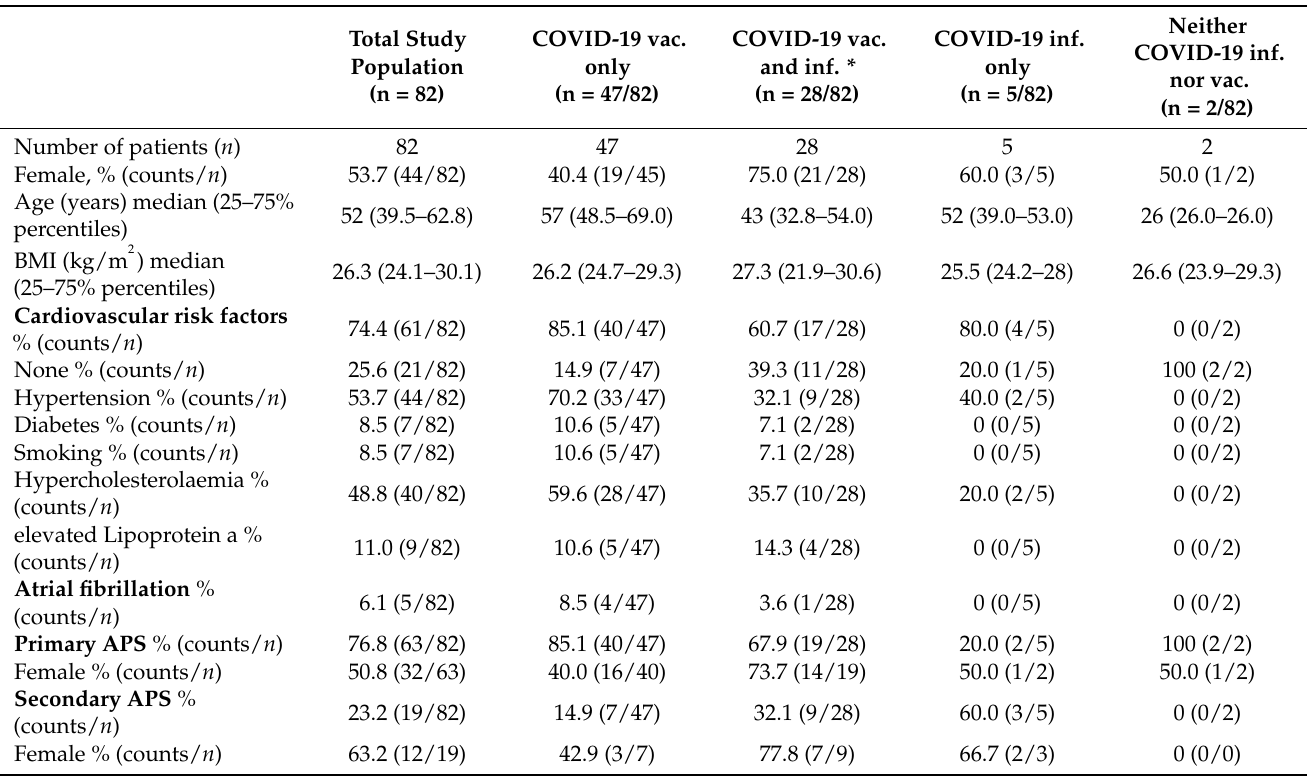
Table 1. Patient characteristics at the